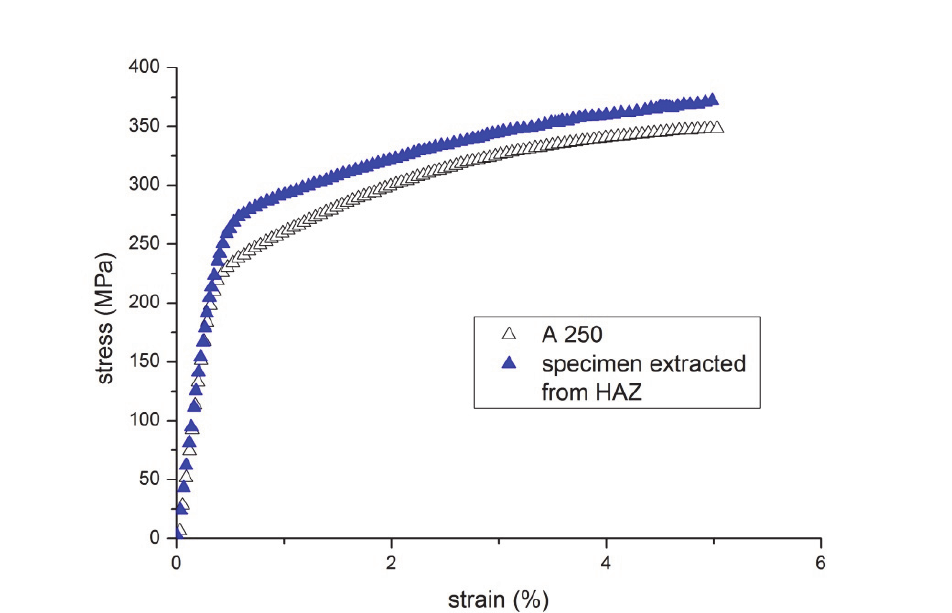
Figure 4: Stress strain curves for materials A 250 and HAZ at the mid-length of hardness gradient.